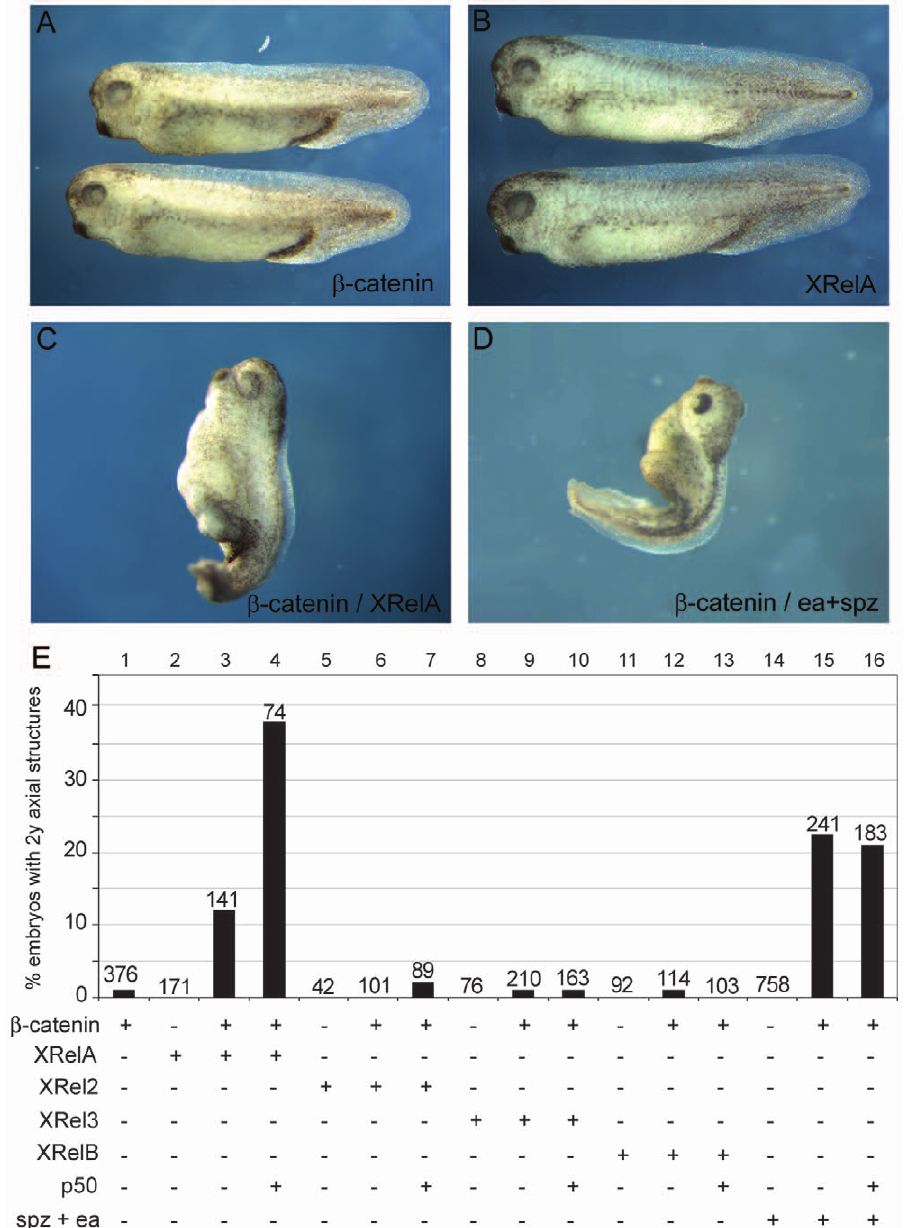
Figure 2. Synergism of XRel and b -Catenin proteins in ectopic axis formation. Suboptimal levels of b -Catenin synergize with XRel proteins or Drosophila Easter/Spa¨tzle to induce axial structures on the ventral side. Embryos injected ventrally with low levels (4 pg) of b -Catenin ( A ) or 500 pg of XRelA ( B ), XRel2, XRel3, XrelB RNAs were indistinguishable from uninjected sibling embryos. Co-injection of 500 pg XRelA with 3 pg of b - Catenin could induce rudimentary axial structures ( C ), as could co-injection of 100 pg each of easter and spa¨tzle with 3 pg of b -Catenin ( D ). Graphical representation ( E ) of all injected combinations, indicating a selective synergism between ectopic b -Catenin and exogenous XrelA/p50 heterodimers, as well as with endogenous NF- k B proteins released by ectopic Ea/Spz.